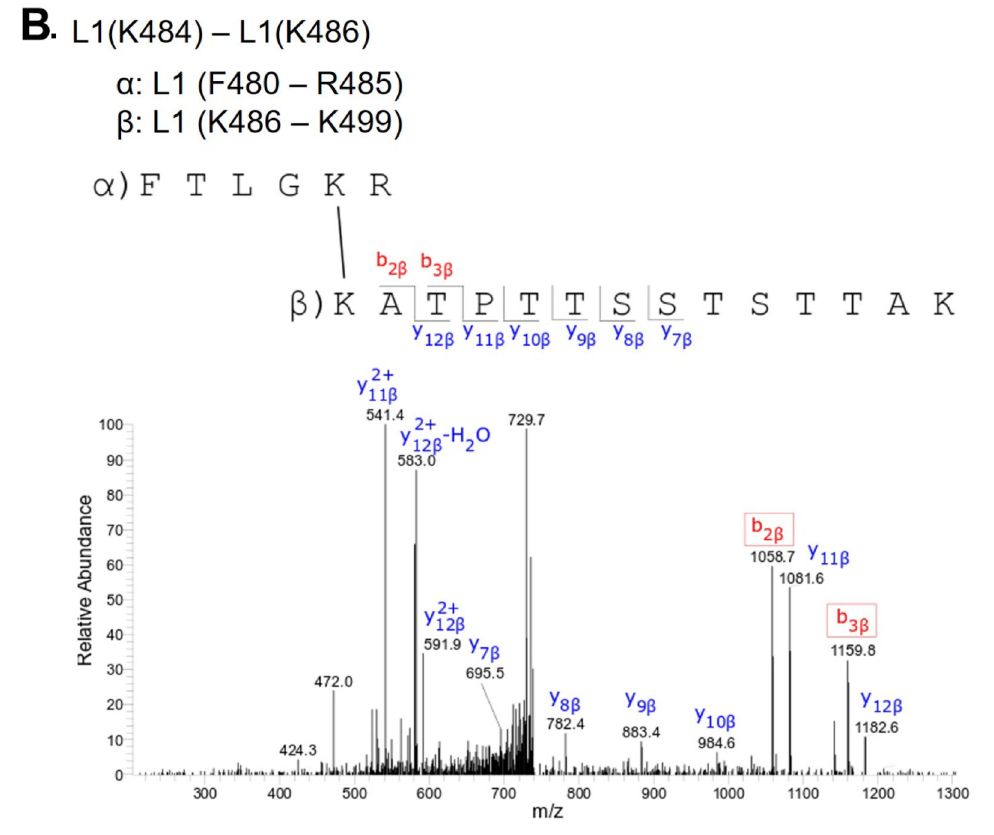
Supplementry Figure 4. Tandem mass spectra of crosslinked peptides identified: Intra-protein cross- links within L1. Observed b- and y-series ions are shown in each spectrum and the fragment ion species containing the crosslinker plus regions of two crosslinked peptides are boxed. (A) MS/MS spectrum of a crosslinked peptide (m/z 484.6, +3 charge) between Lys475 and Lys477 of L1 (Phe468 – Lys479). (B) MS/ MS spectrum of a crosslinked peptide (m/z 747.4, +3 charge) between Lys484 and Lys486 of L1 (Phe480 – Arg485 and Lys486 –